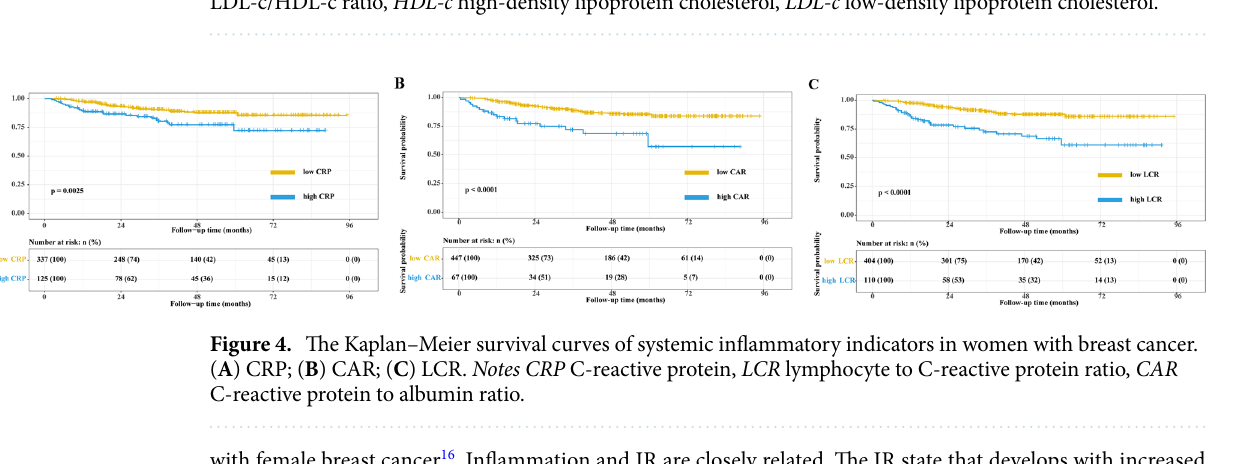
Figure 3. The prognostic AUC curves of systemic inflammatory indicators and IR makers in female breast cancer. ( A ) Systemic inflammatory indicators of CRP, CAR, and LCR; ( B ) IR makers of TyG, LHR, TG/HDL-c, and TC/HDL-c. Notes AUC area under the curve, IR insulin resistance, CRP C-reactive protein, LCR lymphocyte to C-reactive protein ratio, CAR C-reactive protein to albumin ratio, TyG triglyceride-glucose index, LHR LDL-c/HDL-c ratio, HDL-c high-density lipoprotein cholesterol, LDL-c low-density lipoprotein cholesterol.